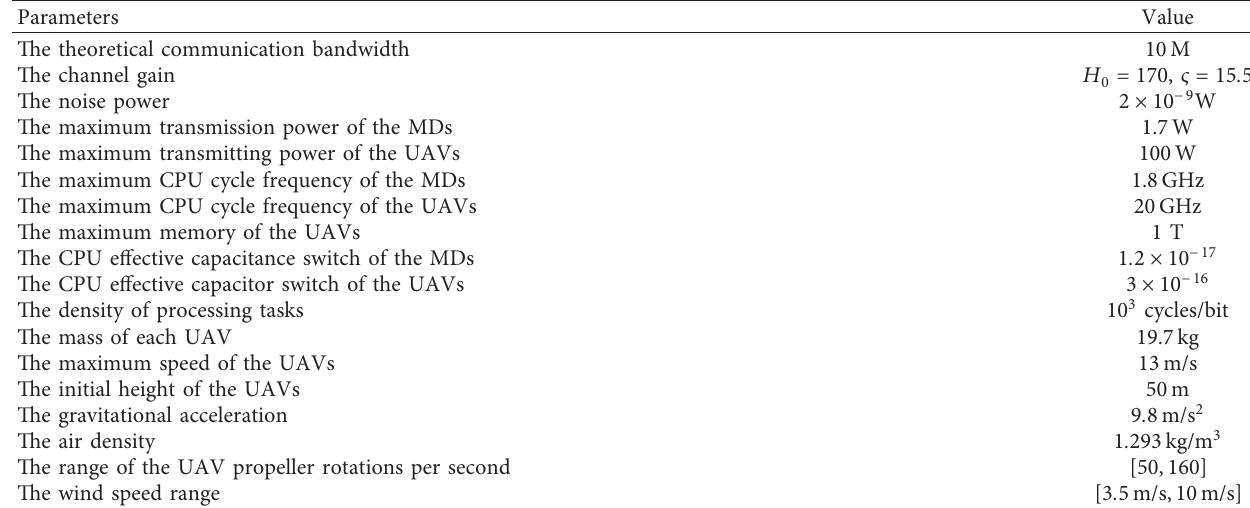
Table 3: The definition of the main experimental